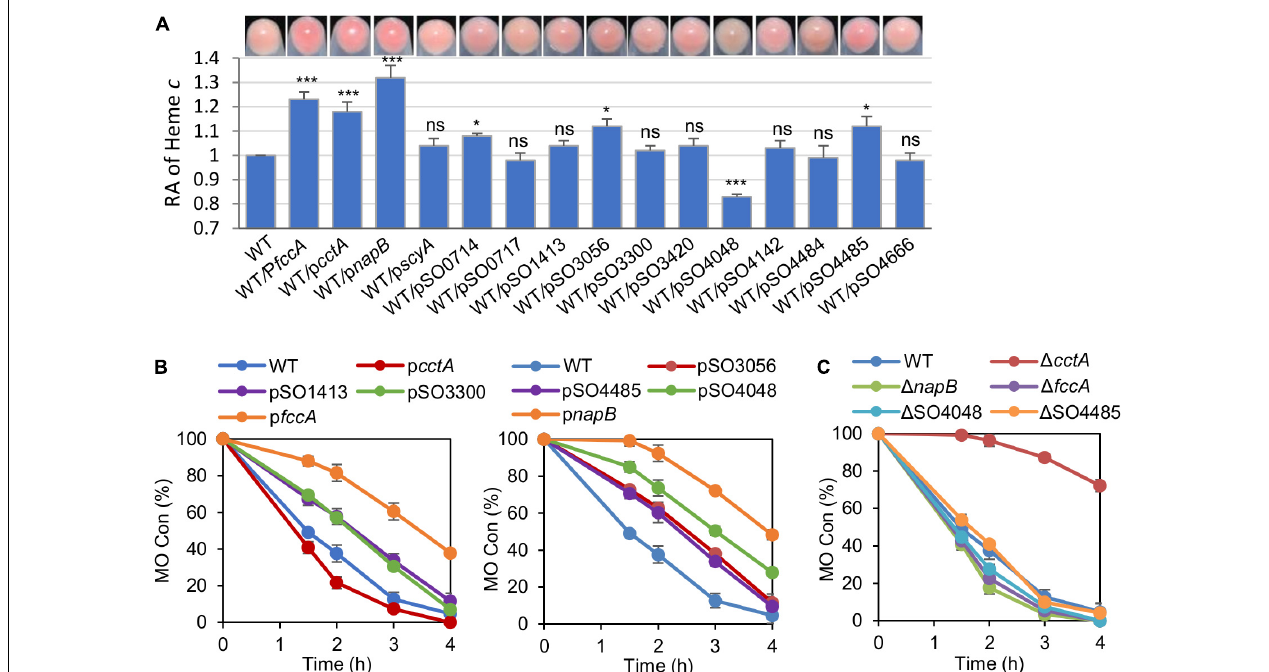
FIGURE 3 | The periplasmic c -Cyts in overabundance interfere with EET efficiency. (A) Cell pellet color and levels of heme c of indicated strains grown anaerobically on TMAO with 0.5 mM IPTG. Data were processed and presented as described in Figure 2A . (B) Methyl orange (MO) kinetic traces of the indicated strains grown with 0.5 mM IPTG. (C) MO kinetic traces of indicated periplasmic c -Cyt single mutants grown with 0.5 mM IPTG. Three independent operations were performed, and data are presented by the means ± SD. In panel (A) , asterisks indicate statistically significant difference when compared with the WT values (ns, not significant; * p < 0.05; *** p < 0.001). In both (B,C) , the differences in the peak values between two strains were <